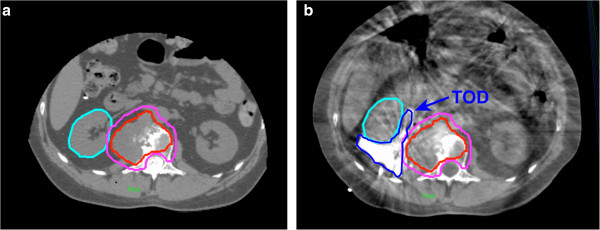
Axial imaging of paraspinal non-seminomatous germ cell tumor treated to 2850 cGy. (a) Baseline computed tomography (CT) scan revealing paraspinal target lesion adjacent to the kidney at L1. (b) Cone-beam CT confirming TOD kidney.